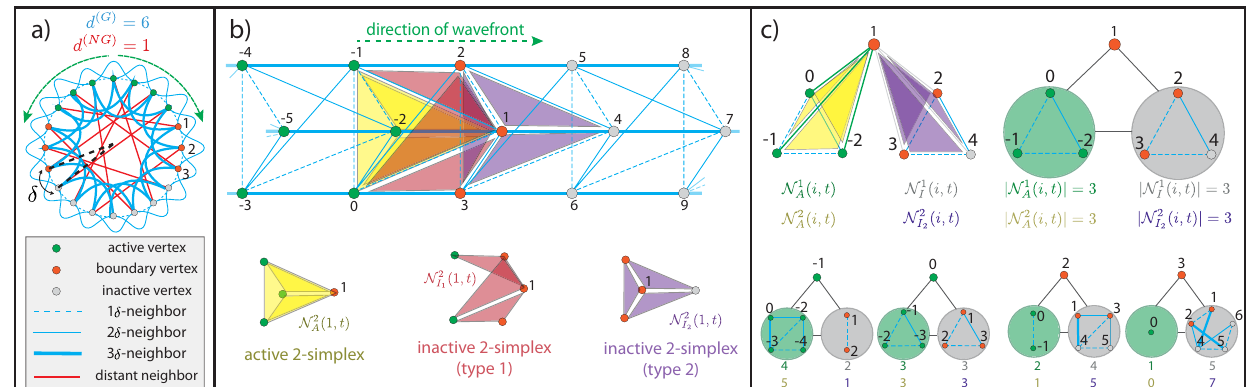
Fig. 7 Bifurcation theory obtained by examining the connections between boundary vertices and active/inactive 1- and 2-simplices. a Visualization of a noisy ring complex with d ( G ) = 6 and d ( NG ) = 1 with N vertices that are spaced apart by an angle δ = 2 π / N . Linestyles highlight that edges connect neighbors with different proximity, and we label vertices so that vertex v 1 is positioned 1 δ to the right of the wavefront, v 2 is at position 2 δ , and so on. The speed of WFP is determined by the number of boundary vertices { v 1 , v 2 , v 3 } that become active upon the next time step. b Visualization of active and inactive k -simplices for the boundary vertex v 1 that is closest to the wavefront. For each v i , we de fi ne a set N k ð i ; t Þ of adjacent k -simplices that are active A and sets N k ð i ; t Þ and N k ð i ; t Þ of inactive 2-simplices that are type 1 and 2, respectively. (Recall Fig. 2.) c By identifying a set of neighboring active vertices I 1 I 2 (green shaded regions) for a boundary vertex v i , one can compute the number of adjacent 1- and 2-simplices that are active by counting the number of those vertices and the number of edges among them, respectively. One can identify the number of inactive 1-simplices and type 2 inactive 2-simplices in a similar way (gray shaded regions). This approach is depicted for vertex v 1 (top) as well as other nearby vertices (bottom), and the associated numbers are indicated for